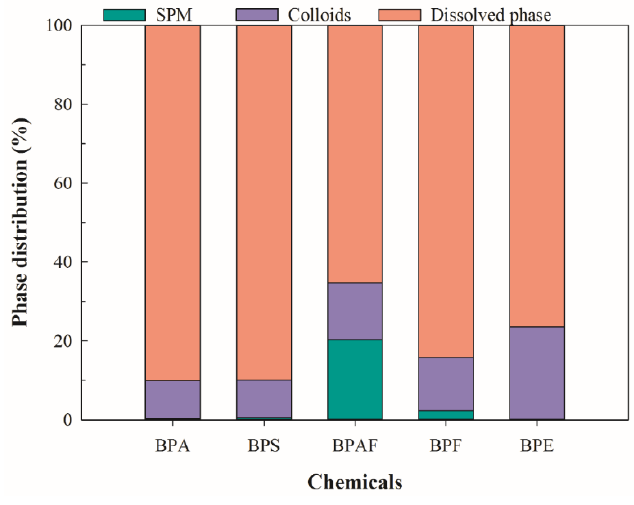
Figure 5. The BPs’ distribution in the SPM, soluble, and colloidal phases of surface water.